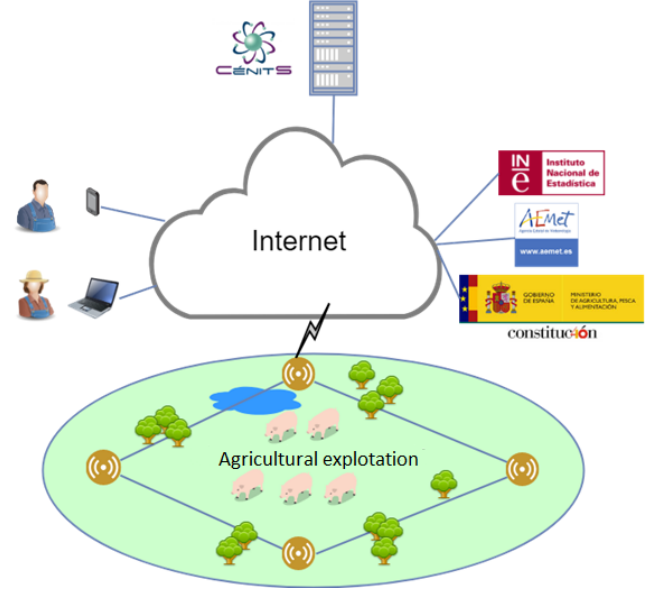
Figure 2. Scheme of the system designed for